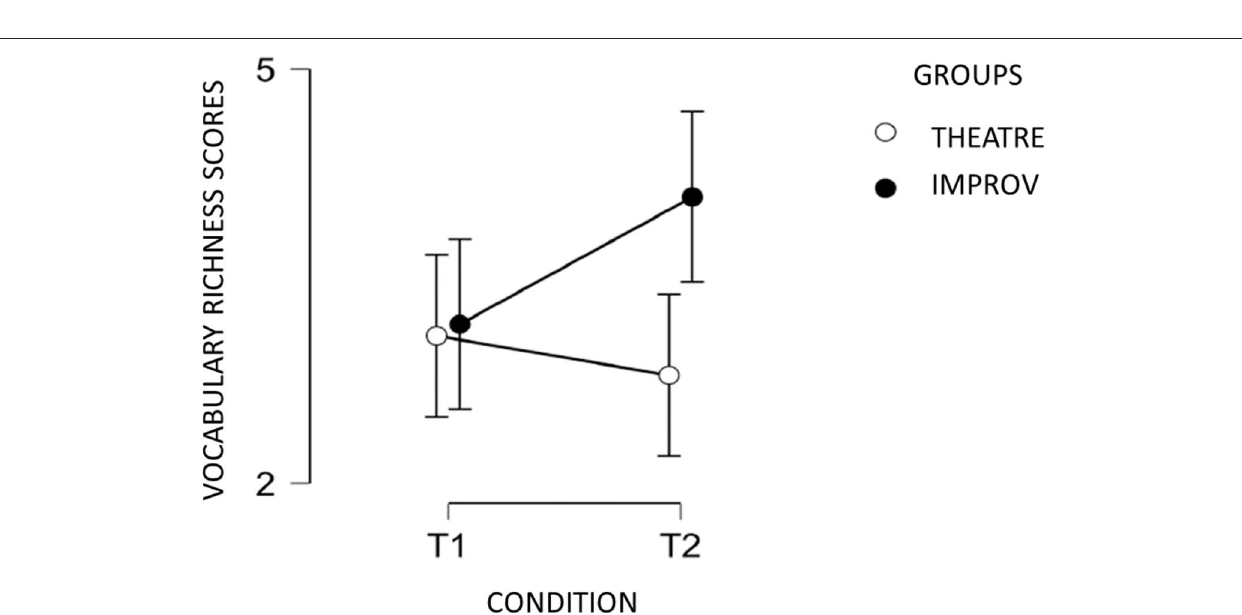
FIGURE 2 | Vocabulary Richness scores at T1 and T2 for improv and theater